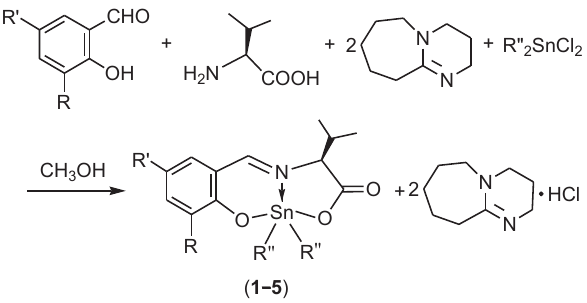
Scheme 1: Synthesis of complexes 1 - 5 . R, R', R'' = H, H, Me ( 1 ); H,